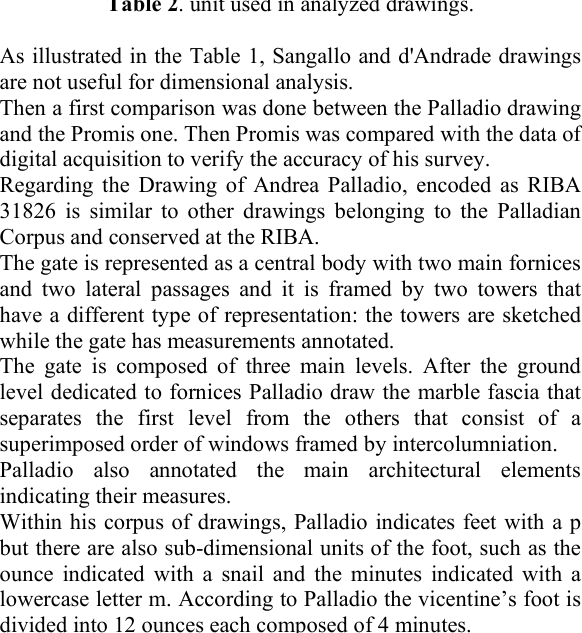
Table 2 . unit used in analyzed drawings.